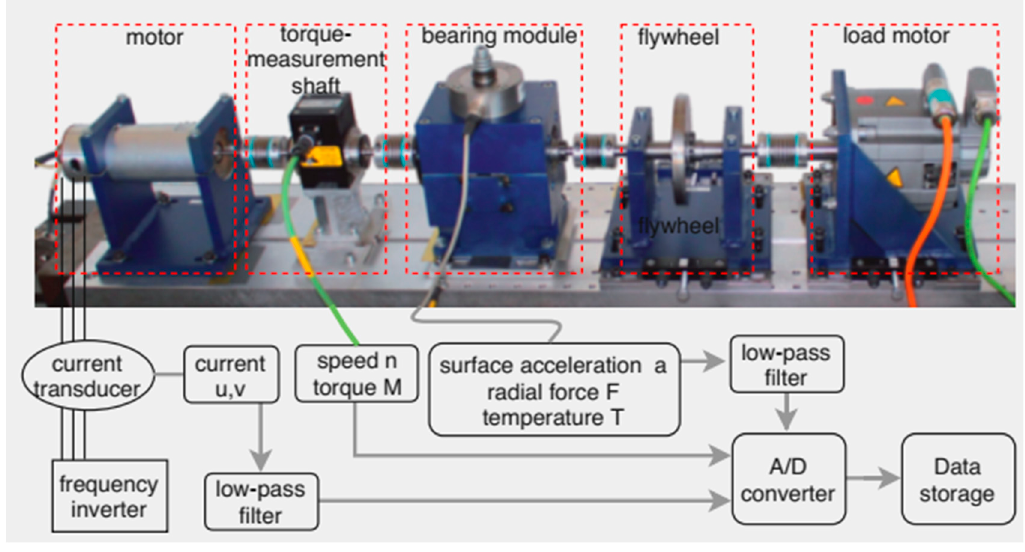
Figure 2. Schematic diagram of signal measurement.